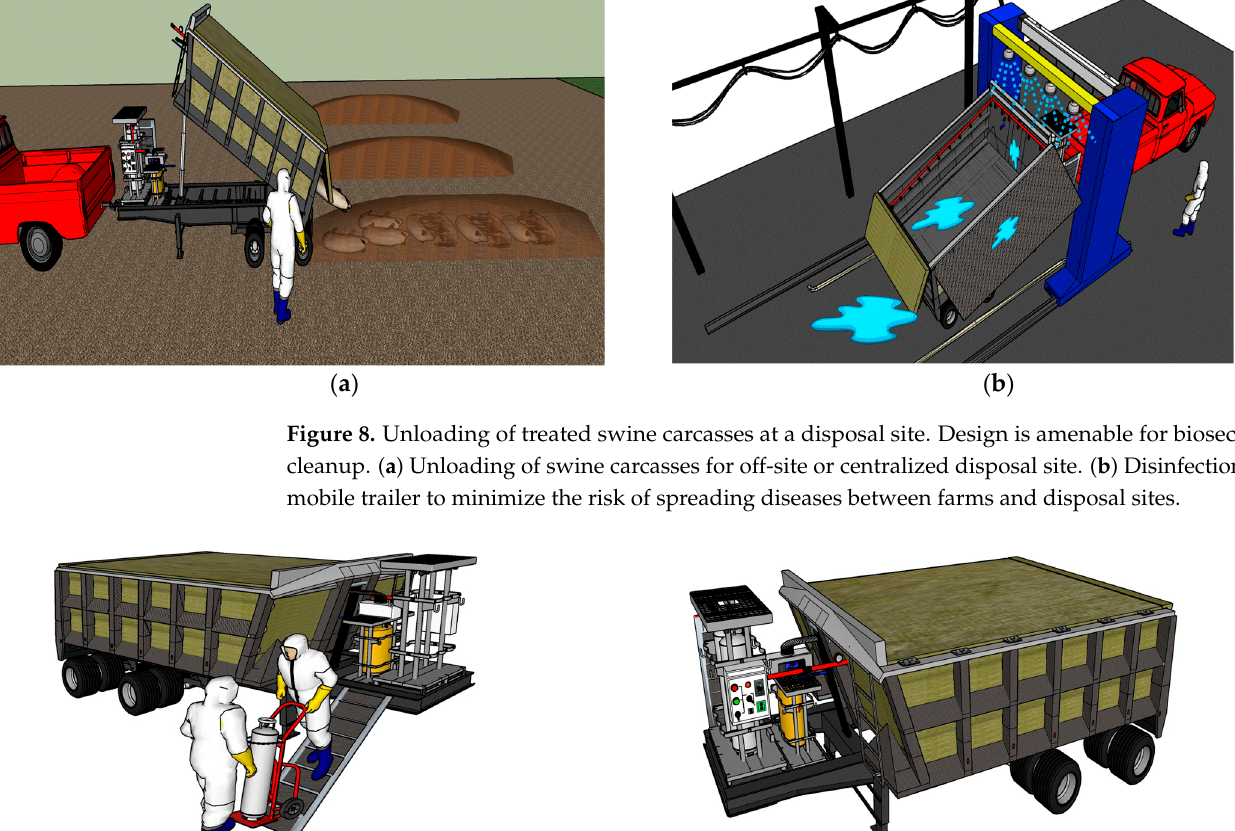
Table 3. Example of CO 2 quantity needed to depopulate a single batch of pigs